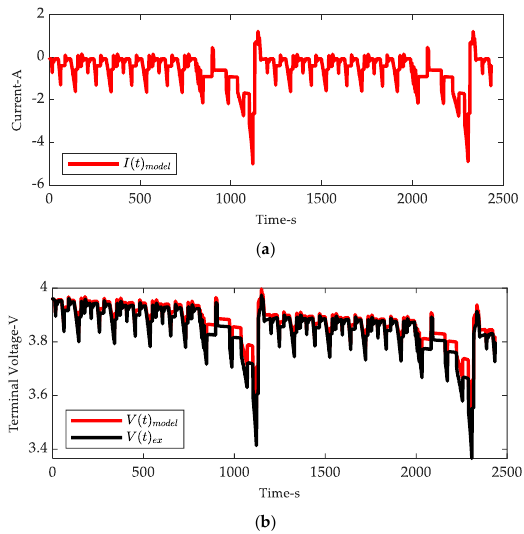
Figure 15. Accuracy test of hardware implementation platform under NEDC schedule at 25 °C ambient temperature. ( a ) NEDC current profile. ( b ) Comparison of model output voltage and actual voltage.